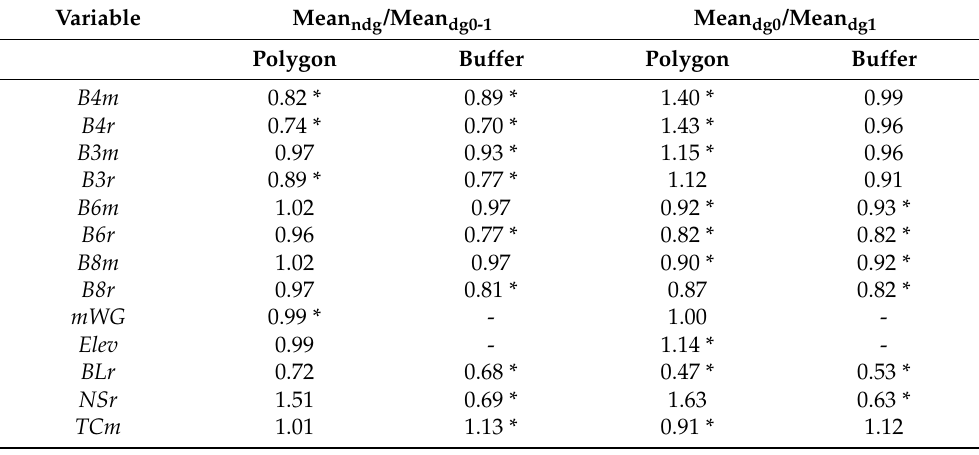
Figure 3. Collinearity table of the S2 variables and FTY and TCD 2015 benchmark variables. Correla- tion coefficients ( r ) below diagonal refer to the sample polygons, those above diagonal refer to their buffer zones. Color shading towards the darker tone indicates | r | > 0.5, and | r | > 0.75; green shading refers to correlations between S2 variables, orange shading to correlation with and between the benchmark variables. Table 2. Predisposing sensitivity of the potential predictor variables to disturbance as indicated by the relative difference of their means and its significance, comparing non-disturbed and disturbed (mean NDG /mean DG0-1 ) and damage severity classes (mean DG0 /mean DG1 ). Significance of the differ- ences in means was tested by Welch’s two-sample t-tests, separately for the sample polygons and their 60 m buffer zones; * marks p <